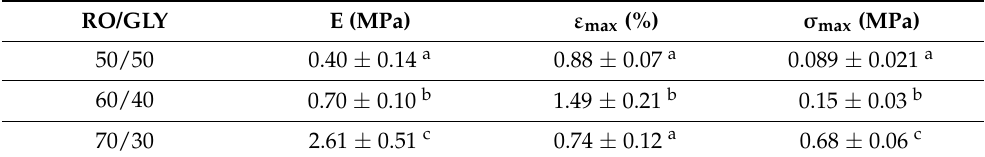
Table 2. Mechanical parameters (Young’s modulus (E), maximum stress ( σ max ) and maximum strain ( ε max )) for bioplastics with different RO/GLY ratios (50/50,60/40,70/30). Different letters within a column indicate significant differences ( p <